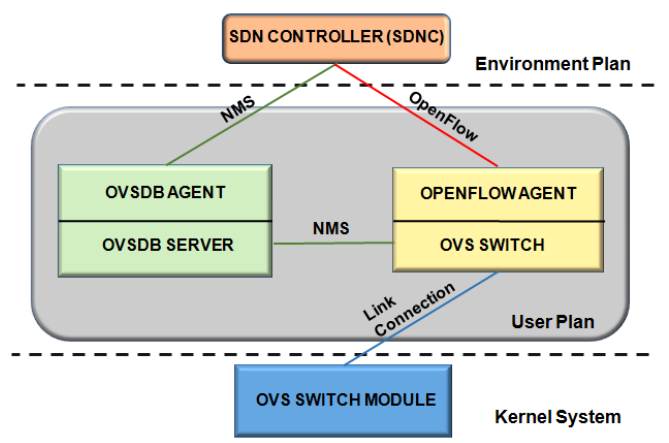
Figure 8. Illustration OVSDB Protocol for IoT